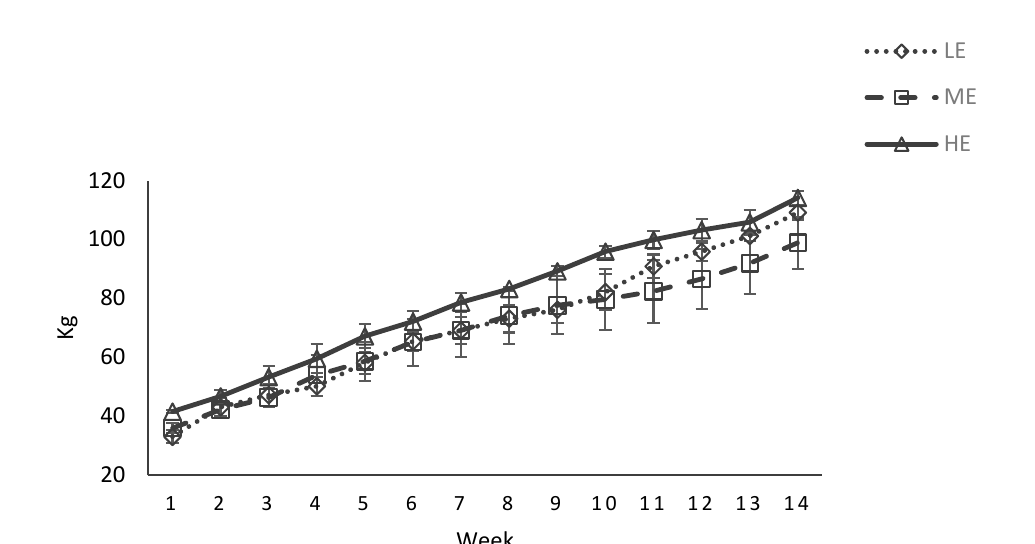
Figure 5. Body weight (BW; kg) of Nili Ravi buffalo calves fed a low energy (LE), medium energy (ME) or high energy (HE) level during 9 weeks prepartum. Low, medium, and high energy levels were NE L : 1.30, 1.42, and 1.53 Mcal/kg, respectively, on DM basis in dietary treatments. Values represent LS means ± SEM.